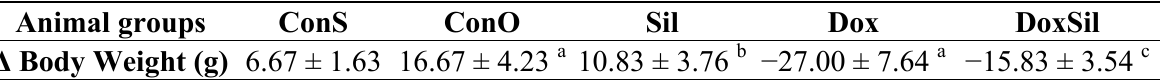
Table 1. Change in the body weight ( Δ ) of the animals of control saline (ConS), control olive oil (ConO) and experimental groups treated with silymarin (Sil), doxorubicin (Dox) and the combination of doxorubicin and silymarin